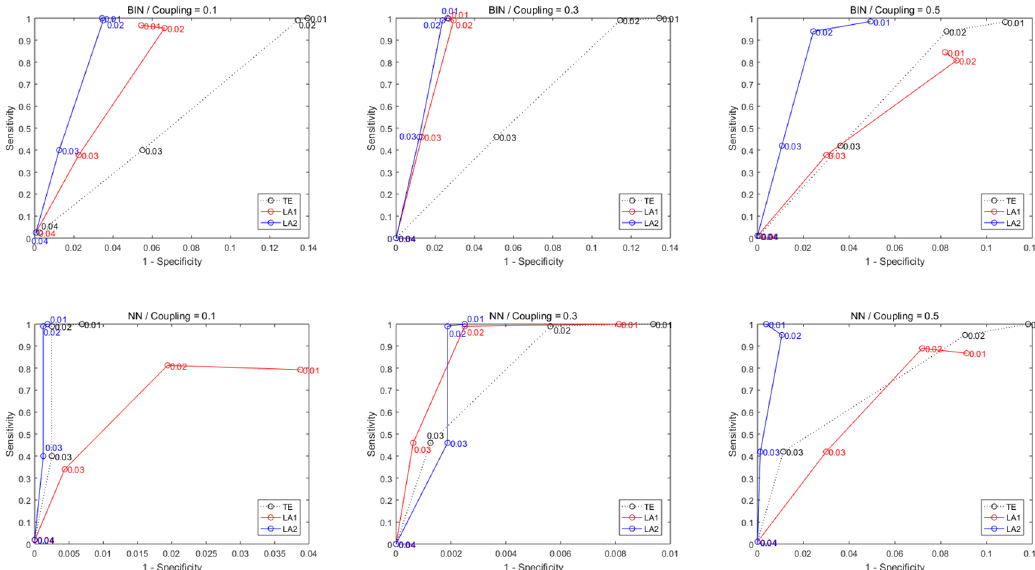
Fig 11. ROC curves for Model E with varying noise and coupling strengths. Sensitivity and specificity are obtained for models with a varying noise from 0.01 to 0.04 (marked in the figure). The first row shows results from the methods applying binning estimator and second row for NN estimator. Column 1 to 3 is with different coupling strength from 0.1, 0.3 to 0.5. Each simulation was performed 100 runs with data length 512.